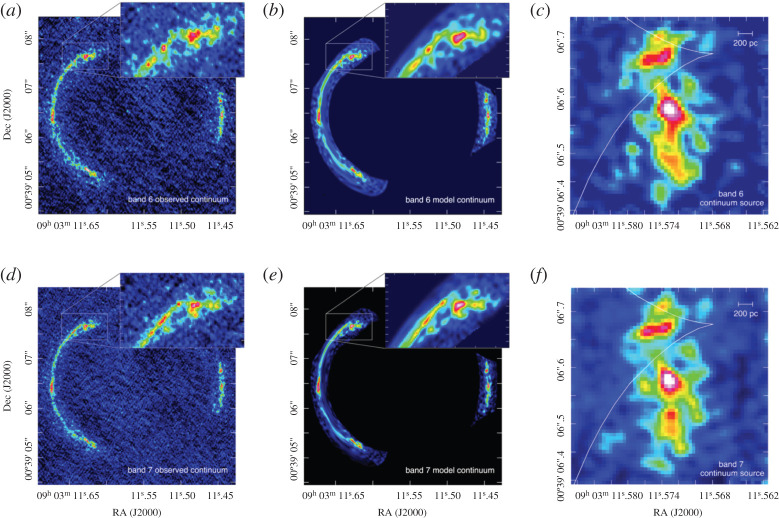
ALMA band 6/7 continuum imaging and source-plane reconstruction of the strongly lensed z = 3.4 SMG SDP.81 from Dye et al. [248]. The highest angular resolution reached is 31 × 23 mass for the Band 7 data, corresponding to an un-magnified spatial scale of 180 pc, and representing a factor of approximately 20–80 increase compared with previous SMA and PdBI imaging of this source. The white lines in the right-hand panels represent the lensing caustic. Figure reproduced from Dye et al. [248].